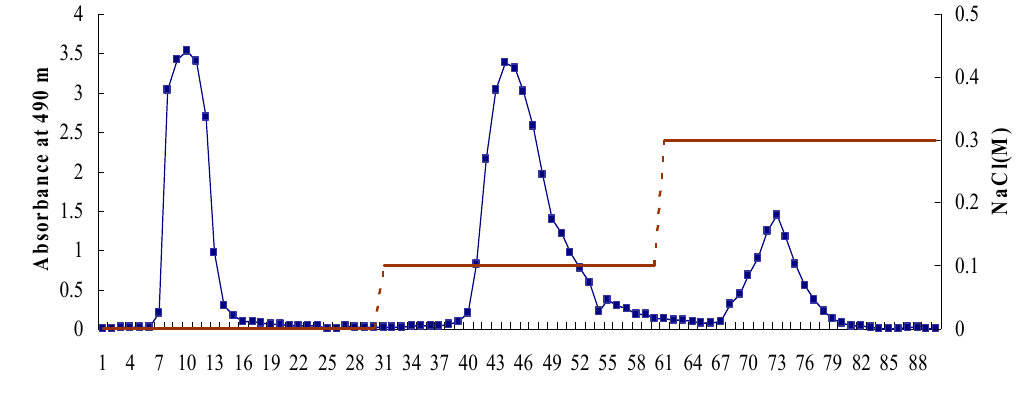
Figure 1. Chromatography of eluted crude polysaccharide (BEBP) on DEAE-Cellulose column (26 mm × 300 mm). BEBP-1 eluted with distilled water; BEBP-2 eluted with 0.1 M NaCl; BEBP-3 eluted with 0.3 M NaCl.